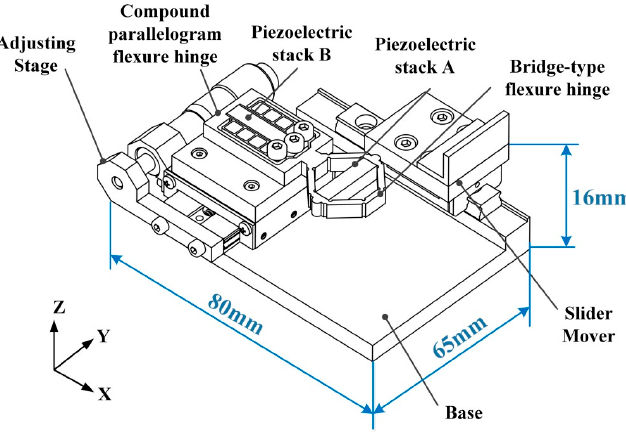
Figure 1. Mechanical structure of the designed actuator.